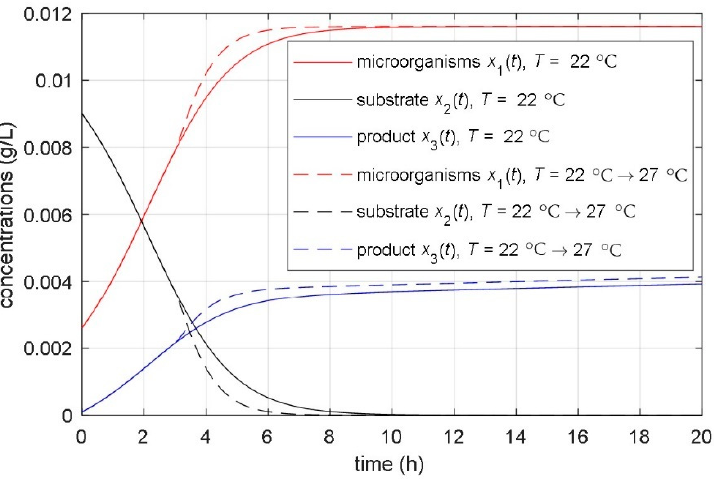
Figure 12. Time courses of the concentrations of the microorganisms, substrate, and product during the fermentation processes with constant and changeable bioreactor